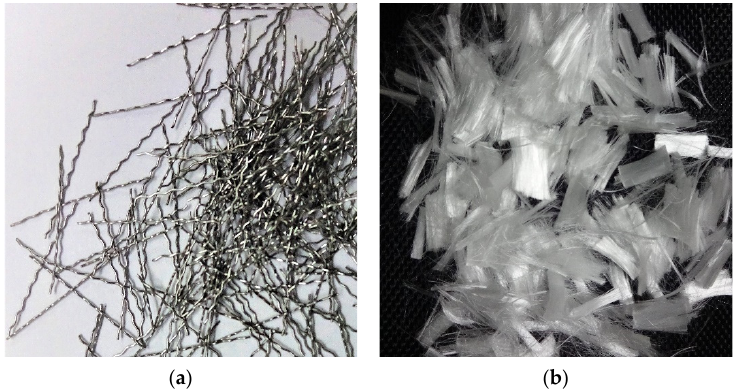
Figure 1. ( a ) Steel fibres and ( b ) polypropylene fibres.